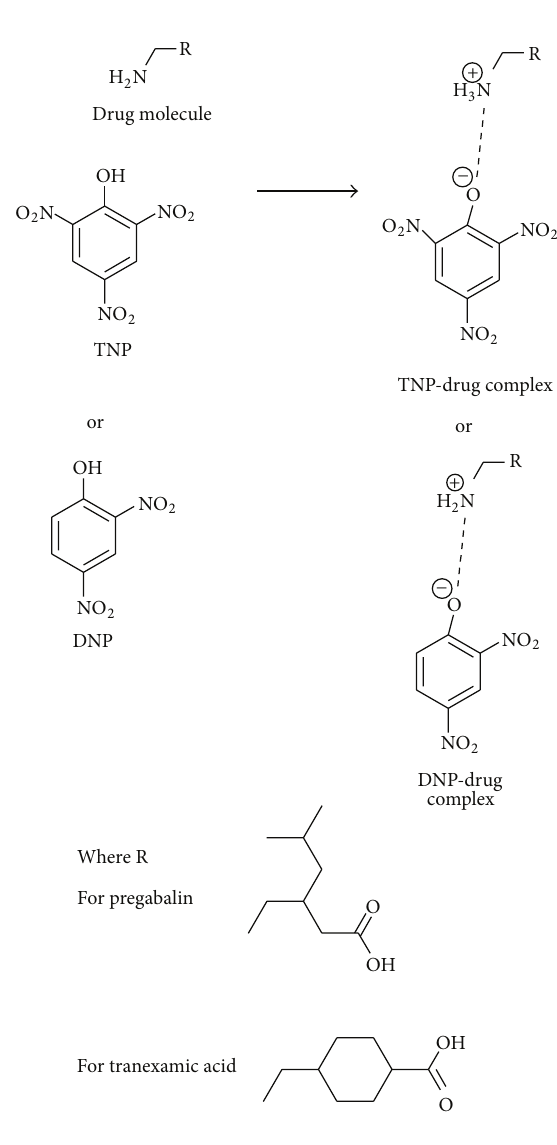
Figure 2: Mechanism of